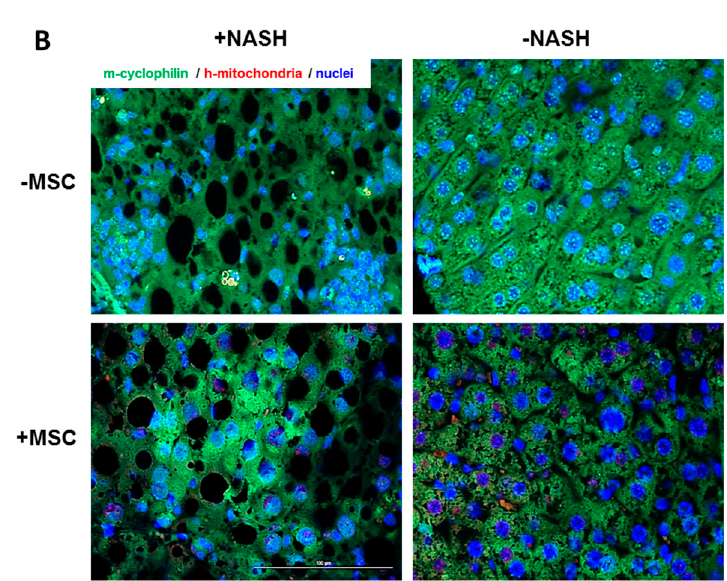
Figure 9. Human MSC-derived mitochondria in mouse hepatocytes of animals receiving MSC transplants. Here, 2- µ m slices of mouse livers either fed the control (-NASH) or the MCD diet ( + NASH) and treated without (-MSC) or with ( + MSC) human bone marrow-derived MSC were co-stained with the anti-mouse cyclophilin or the anti-human mitochondria antibody and images captured using the Zeiss Axio Observer.Z1 microscope equipped with ApoTome.2 with a 40 × objective. ( A ) Black and white images of pictures shown in (B) indicate human mitochondria (lower panels) in livers, which were transplanted with human MSCs. Non-transplanted livers (upper panels) were void of signals; ( B ) Immuno-fluorescent co-stain of mouse cyclophilin (green channel), and human mitochondria (red channel) indicating human mitochondria in mouse hepatocytes; nuclei were stained with DAPI (blue).